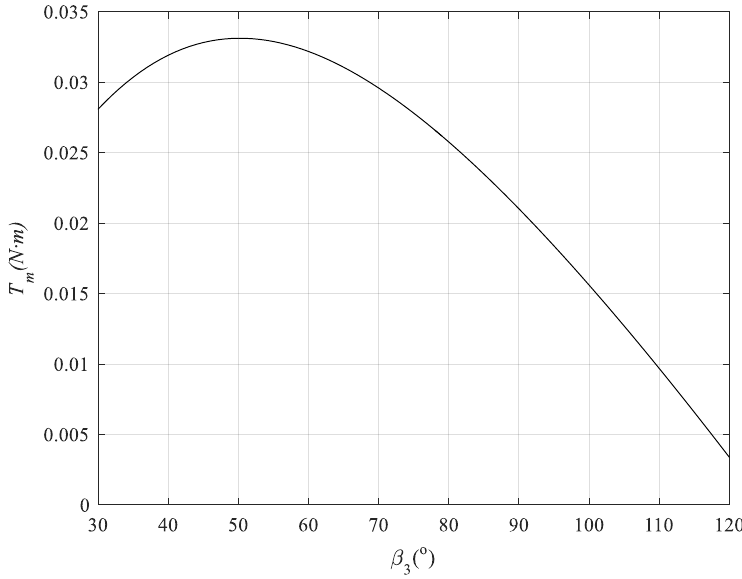
Figure 13. The relation between the motor’s torque and the angle β 3